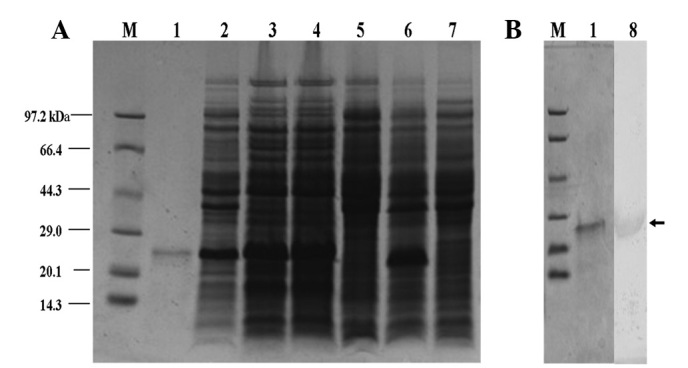
Expression of pET32a-cecropinXJ fusion protein analyzed by Tricine-SDS-PAGE. Lane M: Protein molecular mass marker; lane 1: purified pET32a-cecropinXJ; lane 2: precipitation of bacterial lysate; lane 3: supernatant of bacterial lysate; lane 4: induced BL21(DE3)-pET32a-cecropinXJ (37°C, 0.8 mM IPTG, 5 h); lane 5:uninduced BL21(DE3)-pET32a-cecropinXJ; lane 6: induced BL21(DE3)-pET32a; lane 7: induced BL21(DE3); lane 8: western blot of purified pET32a-cecropinXJ. IPTG, isopropyl-β-D-thiogalactoside.